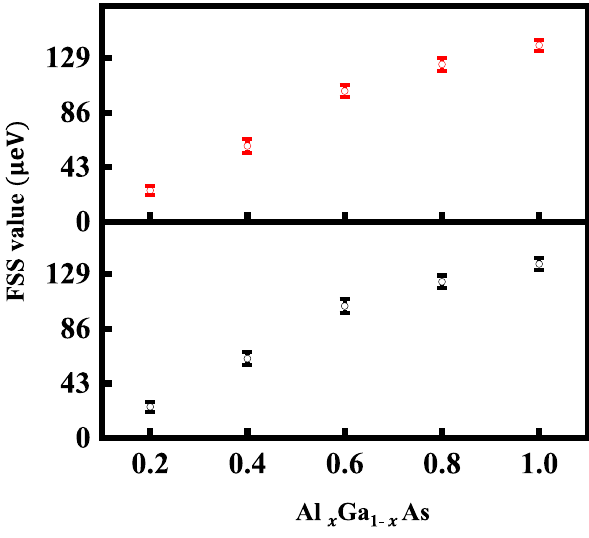
Figure 4: Average FSS values in samples B – F. The average FSS valuesof 30SQDsinsamplesB – F,whichincreaseasa functionofAl component in Al x Ga 1 − x As capping layer. The black and red dots represent X FSS and XX FSS , the oscillations Figure 5(d), for sample G with AlAs capping layer, the typical FSS values for the X line are (27 ± 1.95) μ eV. When decreased the Al component to x = 0.2 of Al x Ga capping layer in Sample H, the measured FSS values are